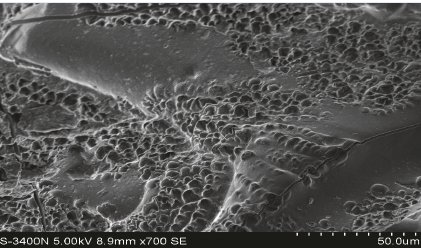
Figure 8: The SEM image of octadecyl methacrylate-acrylamide- N,N 󸀠 -bis(acryloyl)-cystamine